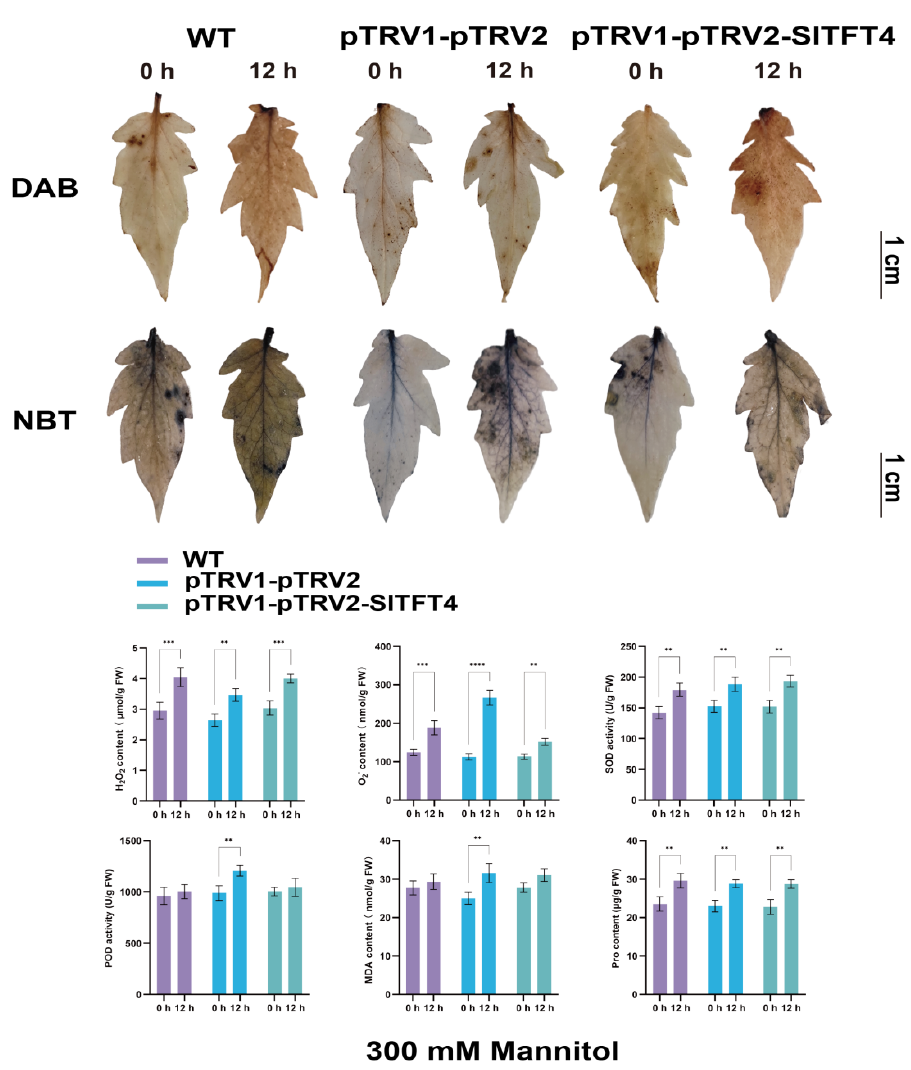
Figure 12. DAB and NBT staining and physiological indices in leaves of different tomato plants under drought stress. WT: untreated wild type plants; pTRV1-pTRV2: control plants injected with an empty vector; pTRV1-pTRV2-SlTFT4: treated plants injected with an SlTFT4 silencing vector. The upper part of the figure shows the DAB and NBT staining of the leaves under different treatment periods of drought stress. The scale bar of the leaves is 1 cm. The physiological indexes of the leaves under different treatment periods of drought stress are measured below. Error bars are the SD of three independent biological replicates, presented as mean ± SD. The statistical significance of differences was confirmed by Dunnett’s multiple comparison test (** p < 0.01, *** p < 0.001, and **** p < 0.0001).